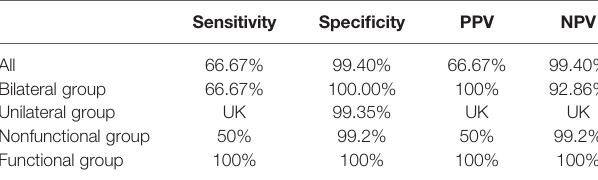
TABLE 4 | The predictive ef fi cacy of the nomogram in validation cohort patient groups. Sensitivity